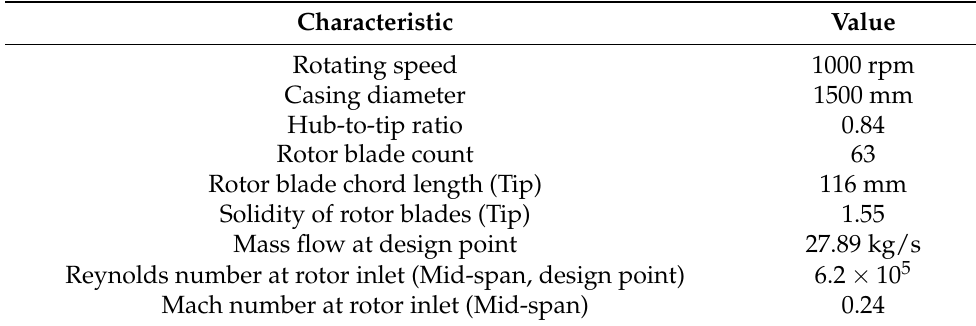
Table 1. Parameters for the single rotor test build of LSRC.